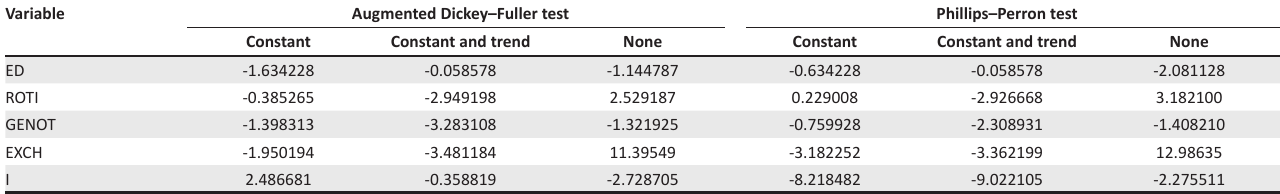
TABLE 1: Unit root tests: Level series. Variable